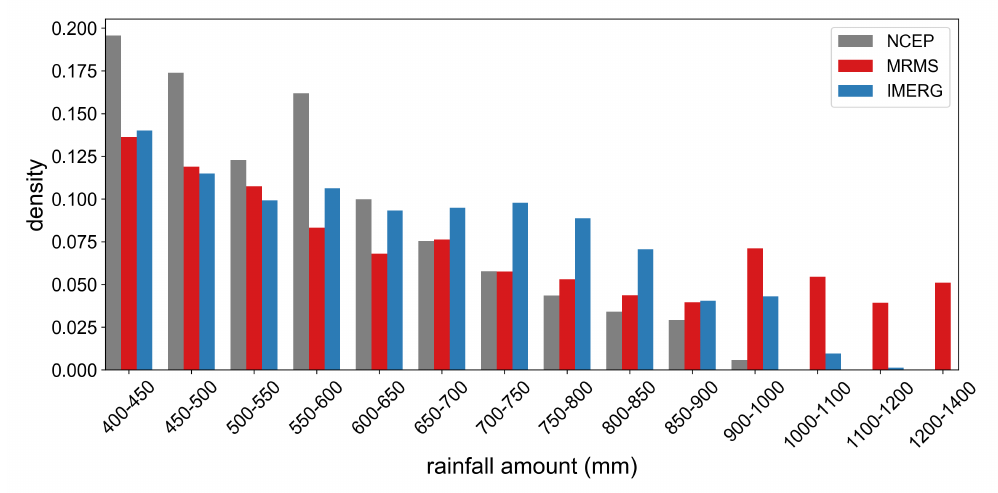
Figure 7. Histogram of accumulative rainfall binned at 50 mm interval from 400 (core) to 1400 mm in Hurricane Harvey. Vertical axis indicates the density.